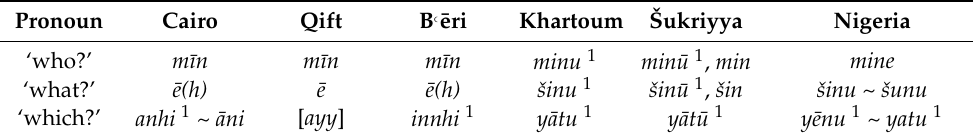
Table 5. Interrogative